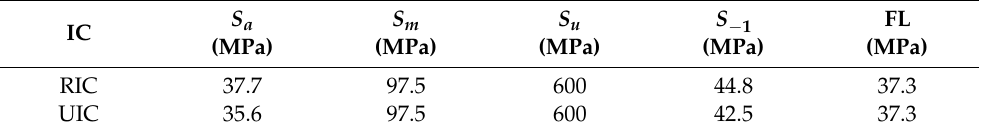
Figure 24. Stress at the hot spot under UIC (ice thickness was 0.32 m and ice velocity was 0.63 m · s − 1 ). Table 8. OWT fatigue limits under ice conditions.